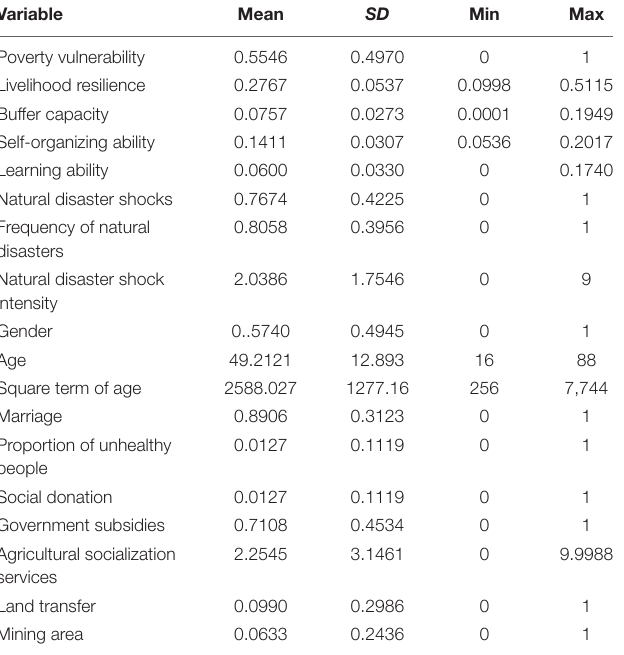
TABLE 2 | Descriptive statistics. TABLE 3 | Impact of natural disasters on the vulnerability of farm households to